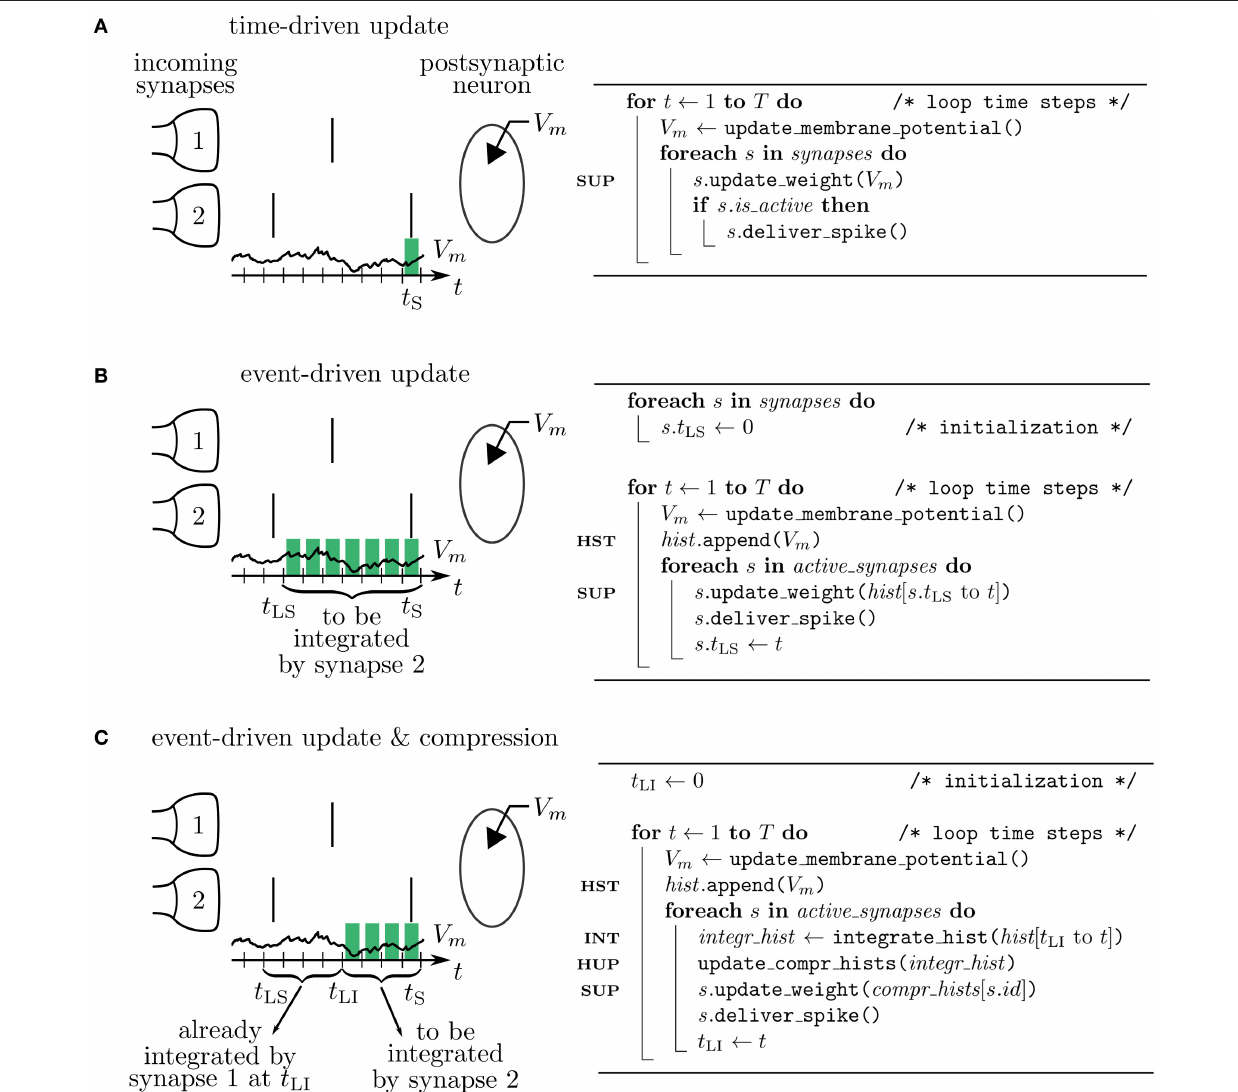
FIGURE 4 | Simulation concepts. Left: illustration of processing the postsynaptic voltage trace V m ( t ) for three simulation concepts. Two incoming synapses (1 and 2) transmit spikes (black, vertical bars) to the postsynaptic neuron. Depending on the algorithm, a different number of past membrane potentials has to be stored (green blocks) so that synapse 2 can update its weight when it delivers the spike at time t S . Right: corresponding pseudocodes. (A) In the time-driven update scheme the synaptic weight change is evaluated in every time step of the simulation for all the synapses. This requires only the latest value of the membrane potential to